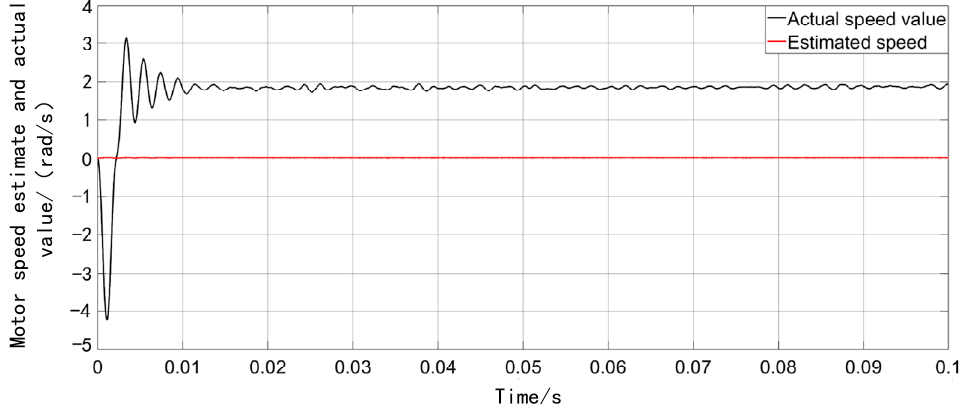
Figure 4. Comparison chart of the motor speed of the traditional SMO observer at low speed.